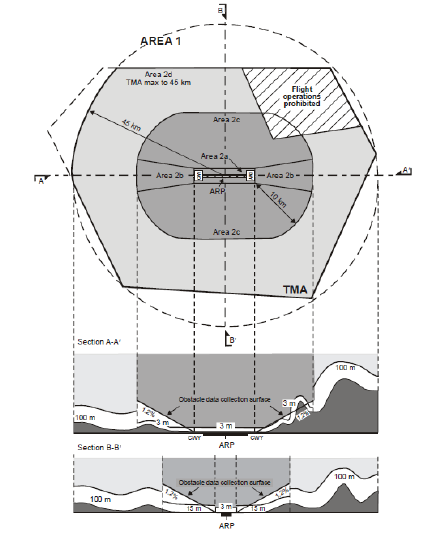
Figure 2. Obstacle data collection surfaces Area 1 and Area